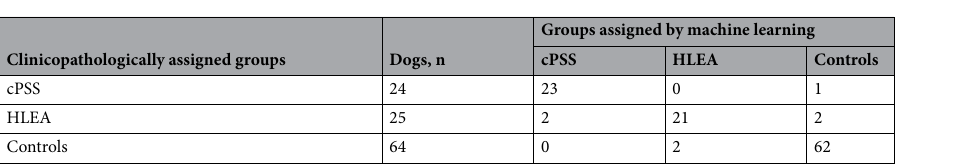
Table 1. Simple logistic regression model to classify dogs with hepatopathies and dogs in the combined control group compared to the clinicopathologically assigned groups. 93.8% samples were correctly assigned using 10-fold cross-validation and solely metabolomics